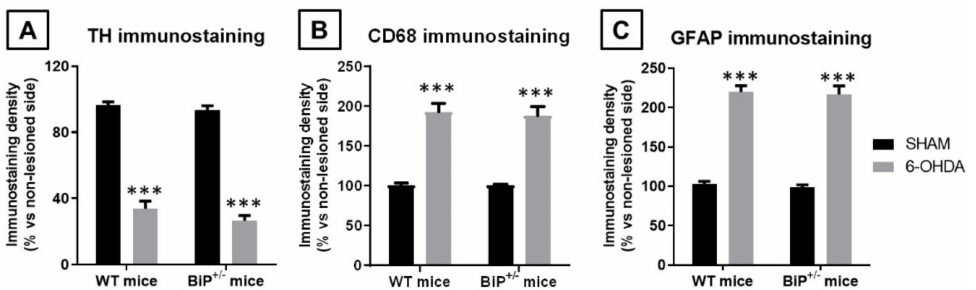
Figure 8. Immunoreactivity for TH (panel ( A )), CD68 (panel ( B )) and GFAP (panel ( C )) measured in a selected area of the substantia nigra pars compacta of wild-type male mice with normal or partial ablation of the BiP protein subjected to unilateral 6-OHDA lesions or sham-operated. Values correspond to % of the ipsilateral lesioned side vs. contralateral non-lesioned side and were expressed as means ± SEM of more than 5 animals per group. Data were assessed by two-way ANOVA followed by the Bonferroni test (*** p < 0.005 vs. the corresponding sham-operated